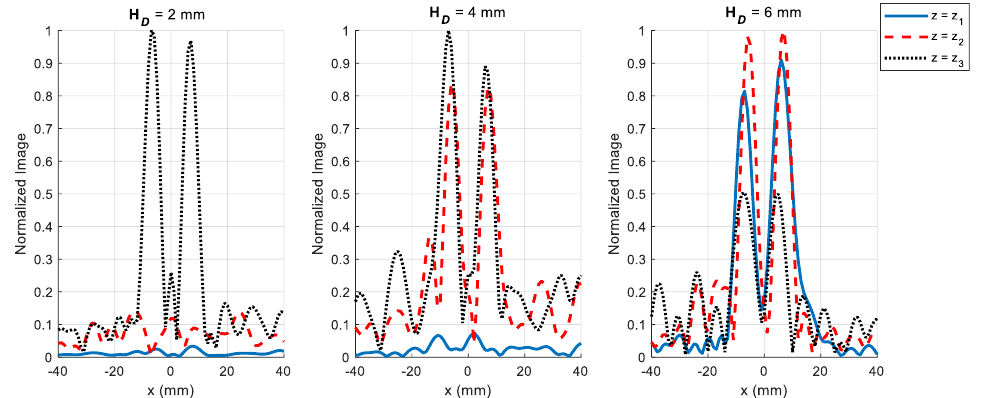
Figure 4. Reconstructed 1D images for defects with 𝑊 𝐷 = 2 mm, 𝐻 𝐷 = 2 mm, 𝐻 𝐷 = 4 mm, and 𝐻 𝐷 = 6 mm.